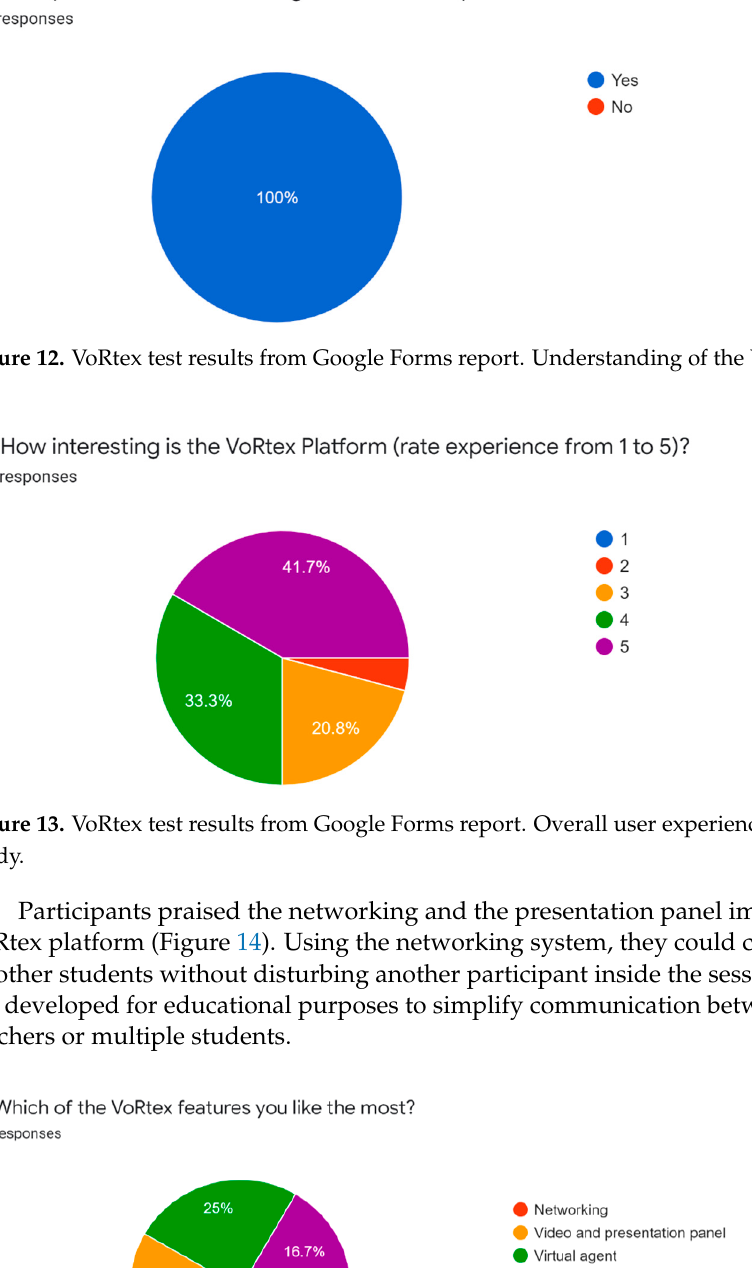
Figure 11. VoRtex test results from Google Forms report. VW in education.